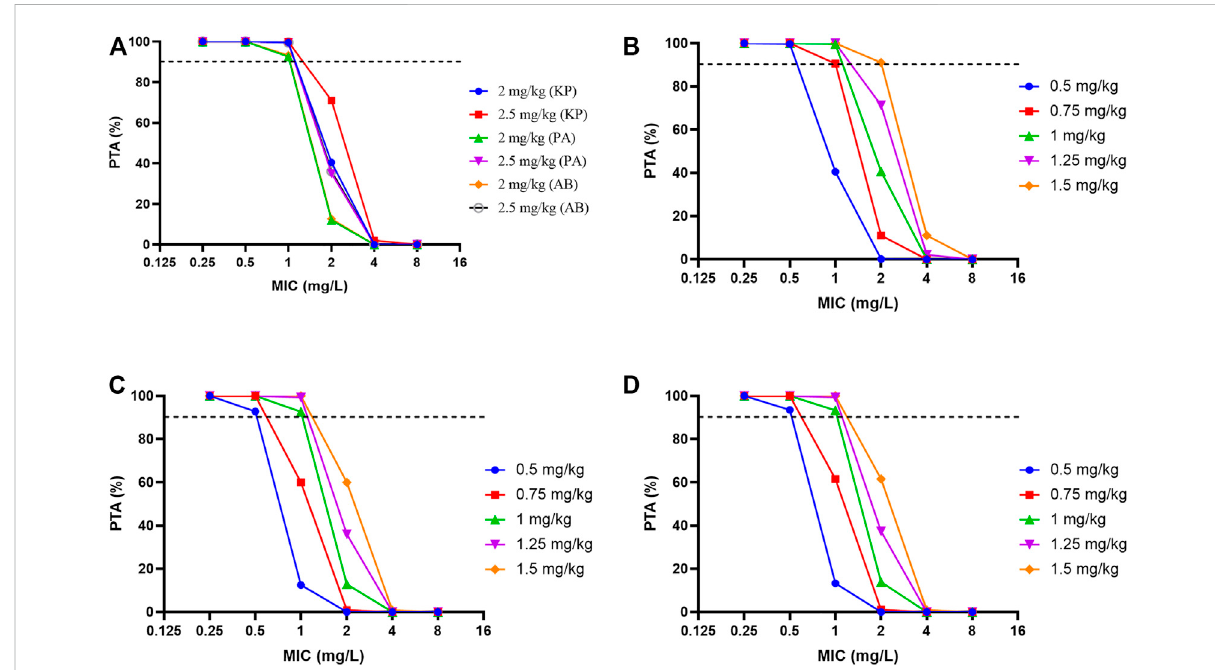
FIGURE 4 Probability of target attainment for different dosage regimens of polymyxin B against common carbapenem-resistant organisms according to PK/PD simulations. (A) Loading dosefor three bacterialspecies. (B) K. pneumoniae (KP), (C) P. aeruginosa (PA), (D) A.baumannii (AB) ; The f AUC ss,24h / MICtargetswere13.5fora1-log 10 reductionagainst K.pneumoniae and17.6and17.4fora2-log 10 reductionagainst P.aeruginosa and A.baumannii , respectively. The unbound fraction in plasma was